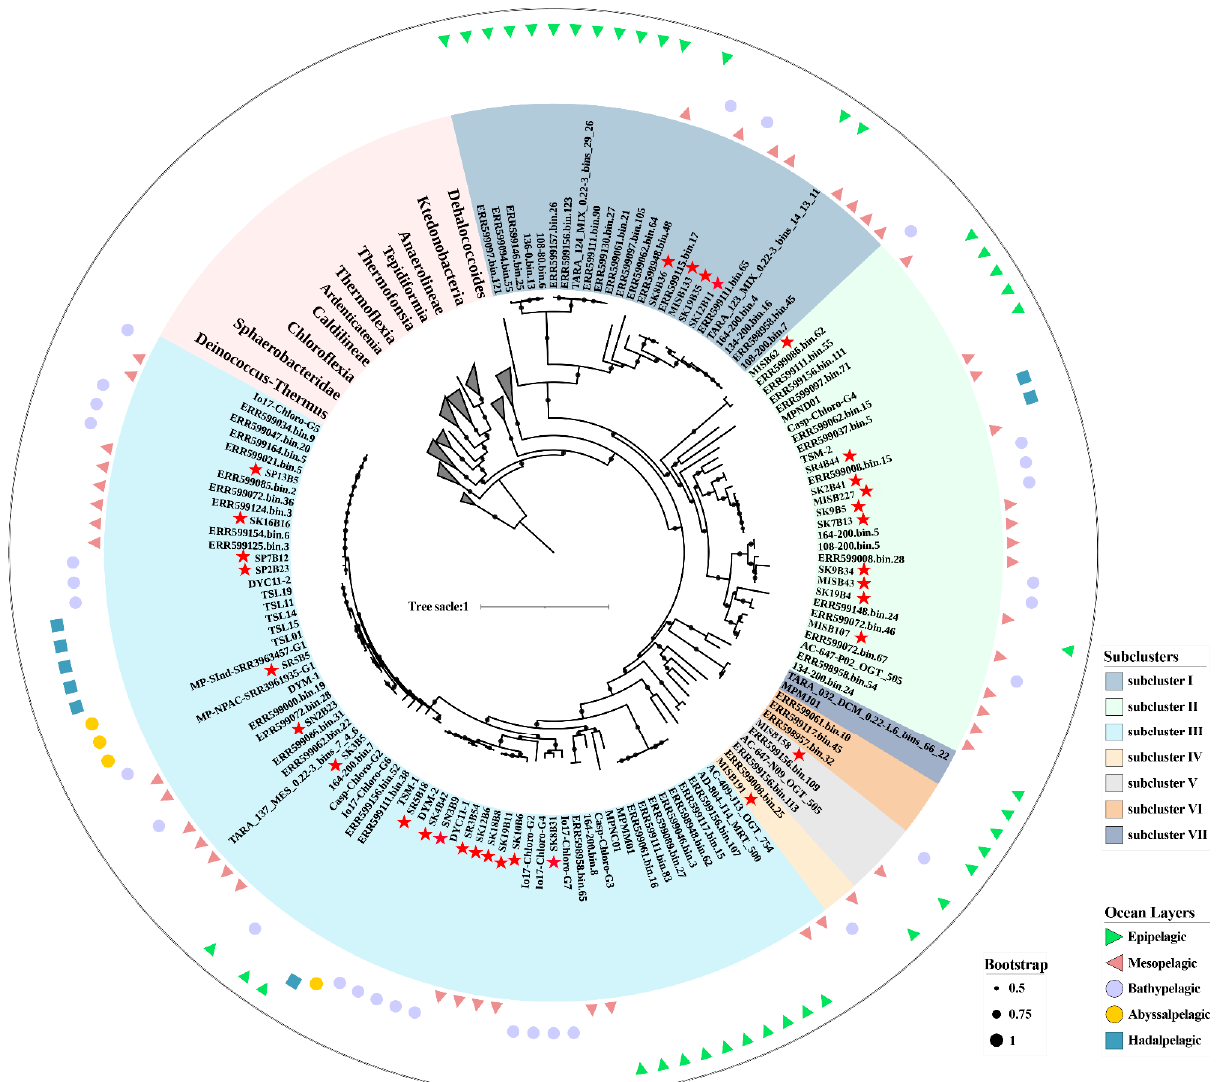
Figure 2. Maximum likelihood phylogenomic tree of SAR202. The phylogenomic tree was constructed based on the concatenated alignment of 43 commonly conserved proteins using IQ-Tree with model selection followed by tree inference based on 1000 replicates. The black dots on the branches denoted bootstrap support and only those >50% were depicted. The SAR202 MAGs in this study were highlighted with a red star. The information of reference genomes was listed in Table